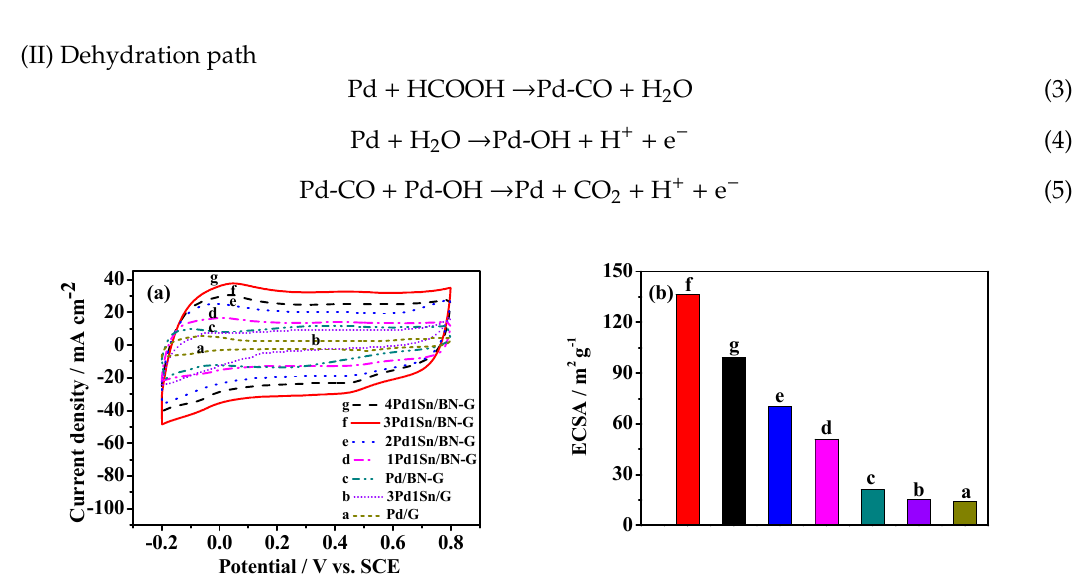
Figure 3. ( a ) Cyclic voltammograms in 0.5 M H 2 SO 4 solution for all the catalysts, scan rate: 50 mV s − 1 . ( b ) Bar plots of the corresponding electrochemically active surface area (ESCA) values.